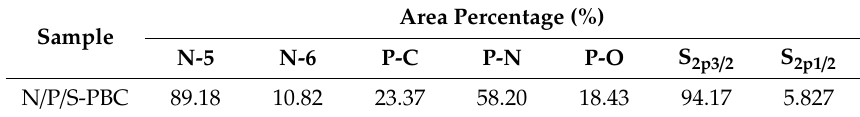
Figure 6. ( a ) XPS survey spectra of the PBC, N/P-PBC, N/S-PBC, N/P/S-PBC and the high-resolution XPS spectra of deconvoluted ( b ) N1s, ( c ) P2p and ( d ) S2p peak of N/P/S-PBC. Table 2. Area percentage of N1s, P2p and S2p peaks in high resolution XPS spectra for N/P/S-PBC.